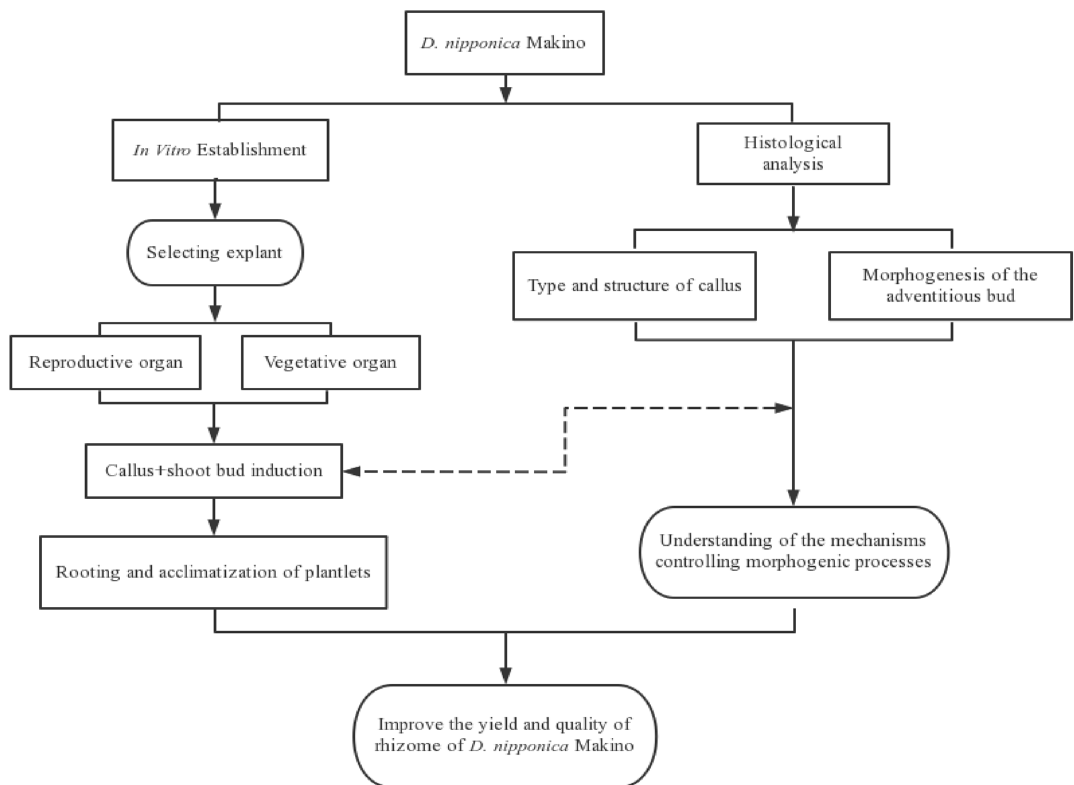
Figure 1. Flow diagram showing the strategy for the experimental